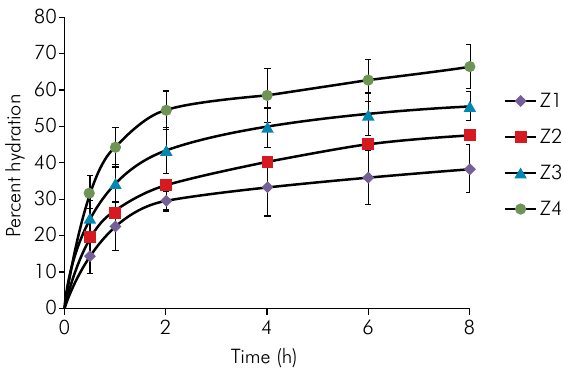
Figure 1. Percent hydration of prepared buccal films over 8 h determined using 1 cm 2 pieces of film. Values represent the mean of six trials ± standard